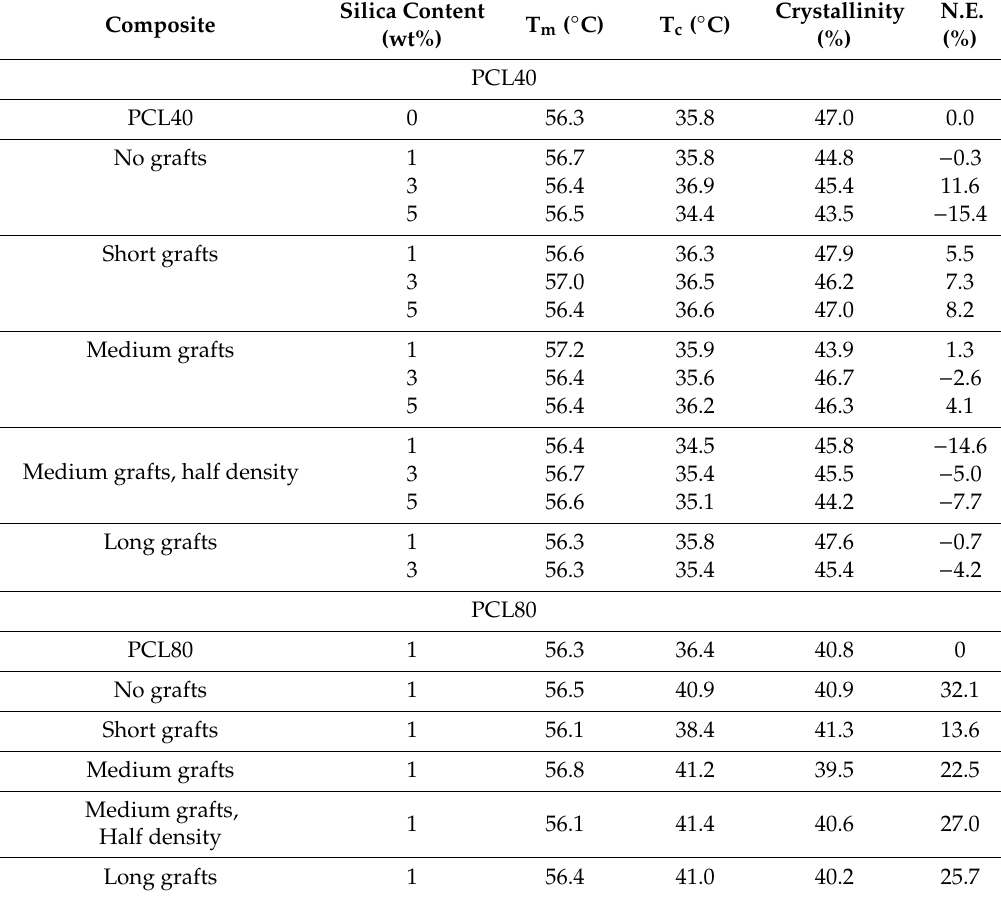
Table 3. Crystallisation parameters for PCL / silica composites based on PCL40 or PCL80